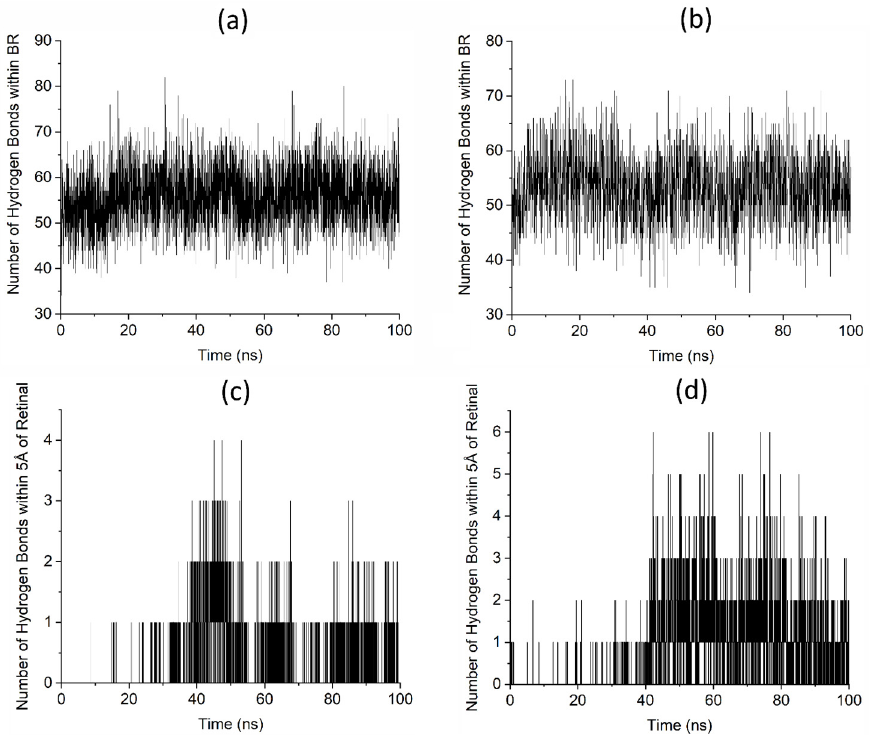
Figure 3. Role of hydrogen bonds in bR–graphene interactions: ( a ) Hydrogen bonds within bR in the absence of graphene; ( b ) Hydrogen bonds within bR in the presence of graphene; ( c ) Hydrogen bonds within 5 Å of the retinal in the absence of graphene; ( d ) Hydrogen bonds within 5 Å of the retinal in the presence of graphene.